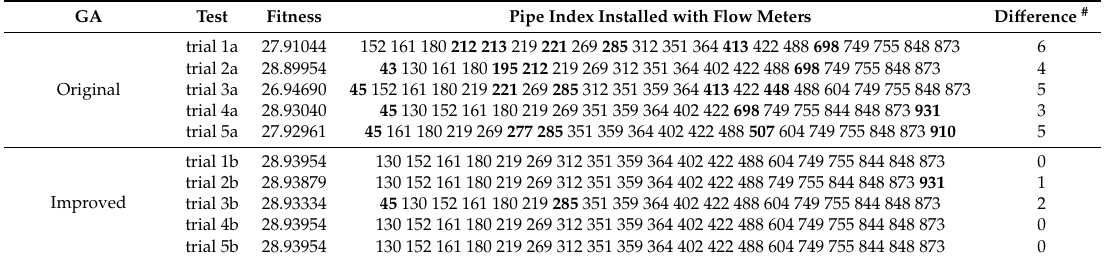
Figure 6. Comparison of pressure and velocity distribution before and after WNP: ( a ) Pressure distribution; ( b ) Velocity distribution with velocity < 0.10 m / s. Table 7. Results comparison of 5 runs between original GA and improved GA for OF4